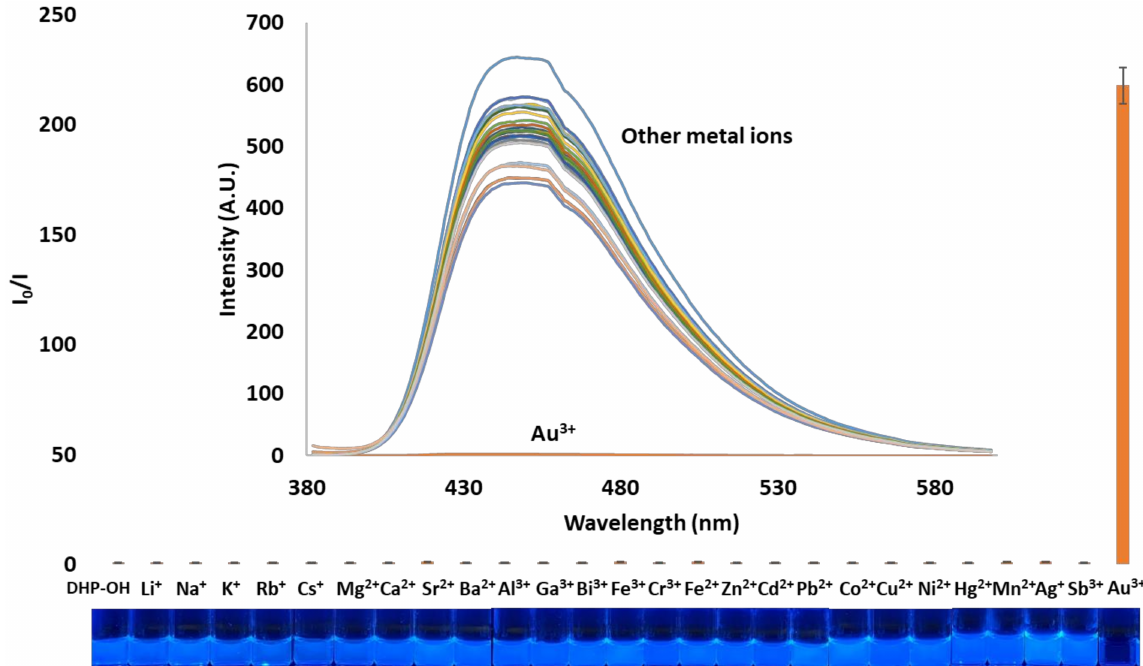
Figure 3. Fluorescence responses of DHP-OH (10 µ M) in the presence of metal ions (100 µ M) in Tris-HCl (pH 6.0) ( λ ex = 369 nm) and fluorescence appearance under